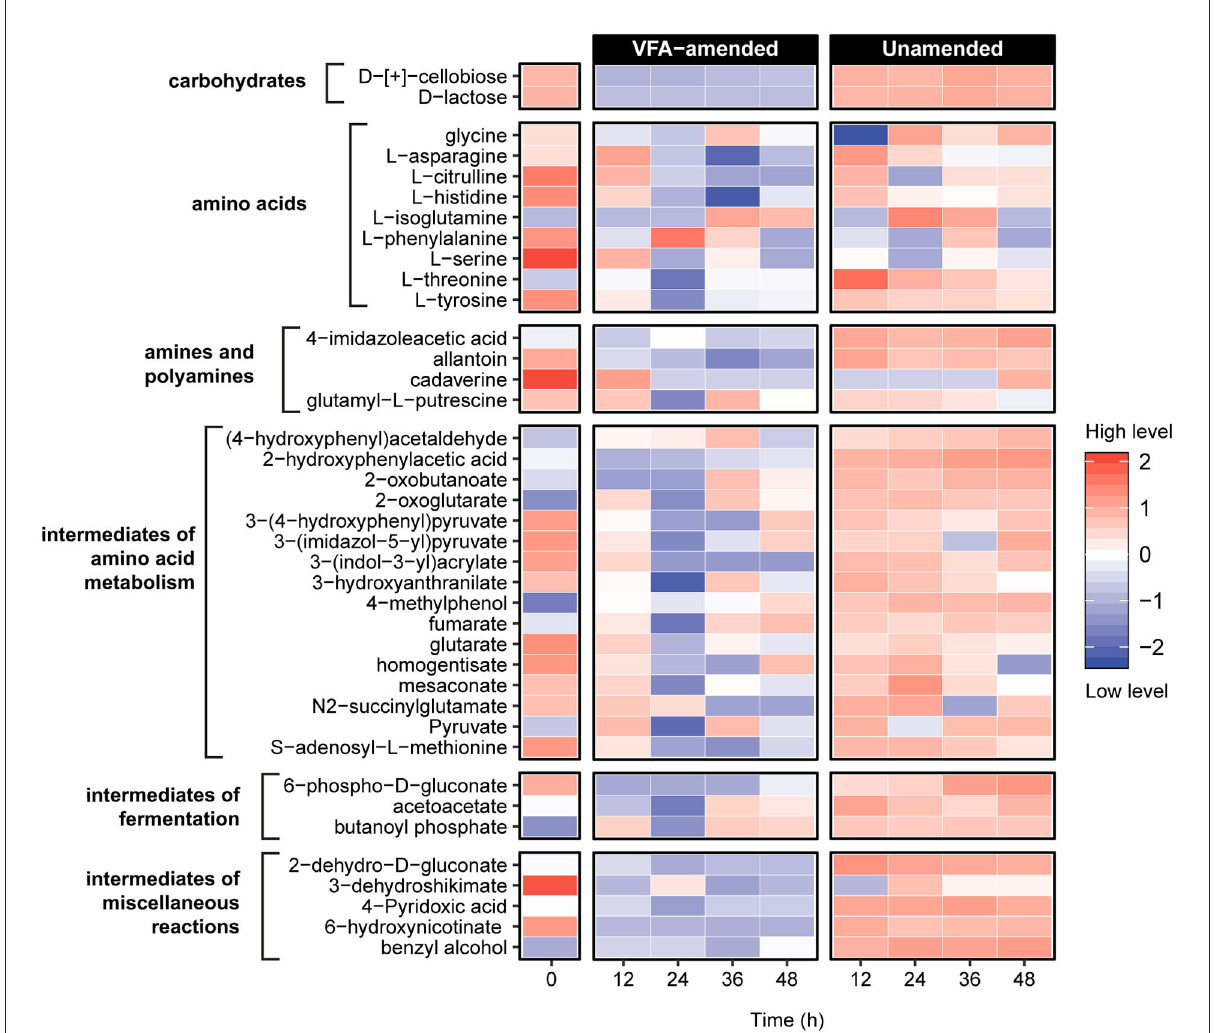
FIGURE3 Untargeted metabolite analysis using UHPLC Orbitrap mass spectrometry revealed 39 compounds related to organic matter decomposition in sediment heating incubations. Metabolite levels at hours 12–48 are expressed as the logarithmically normalized mean fractional abundance of technical replicates ( n = 5). The time zero (after pasteurization) column represents average metabolite levels of VFA-amended ( n = 3) and unamended ( n = 3) slurries. A larger heatmap specifically showing amino acids and intermediate compounds of amino acid metabolism reactions are presented in Supplementary Figure